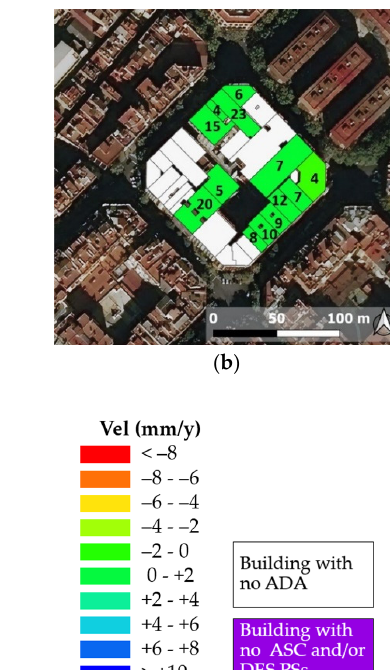
Figure 9. Maps of ( a ) V EW and ( b ) V V components for the “unstable” buildings in Zona Franca area. The violet polygons represent buildings with original lack of PSs.